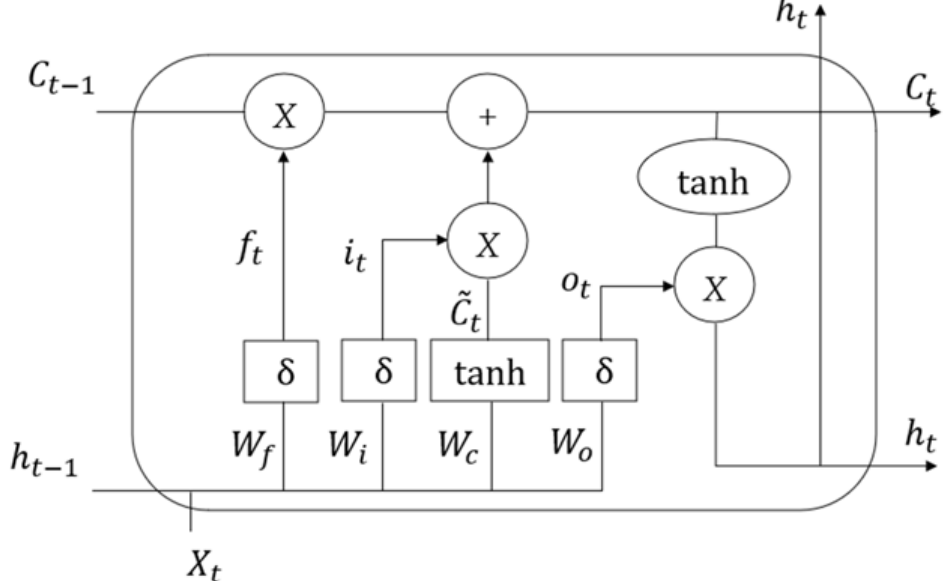
Figure 8. LSTM cell architecture.